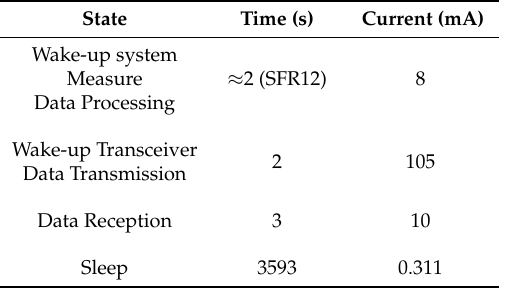
Table 2. Time and current consumption for the node working